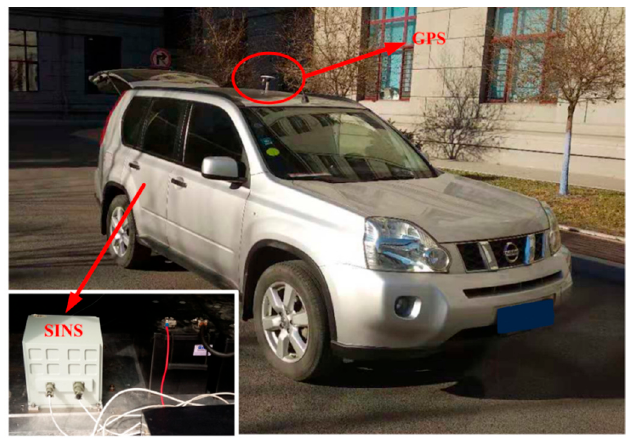
Figure 9. Vehicle experiment and equipment.